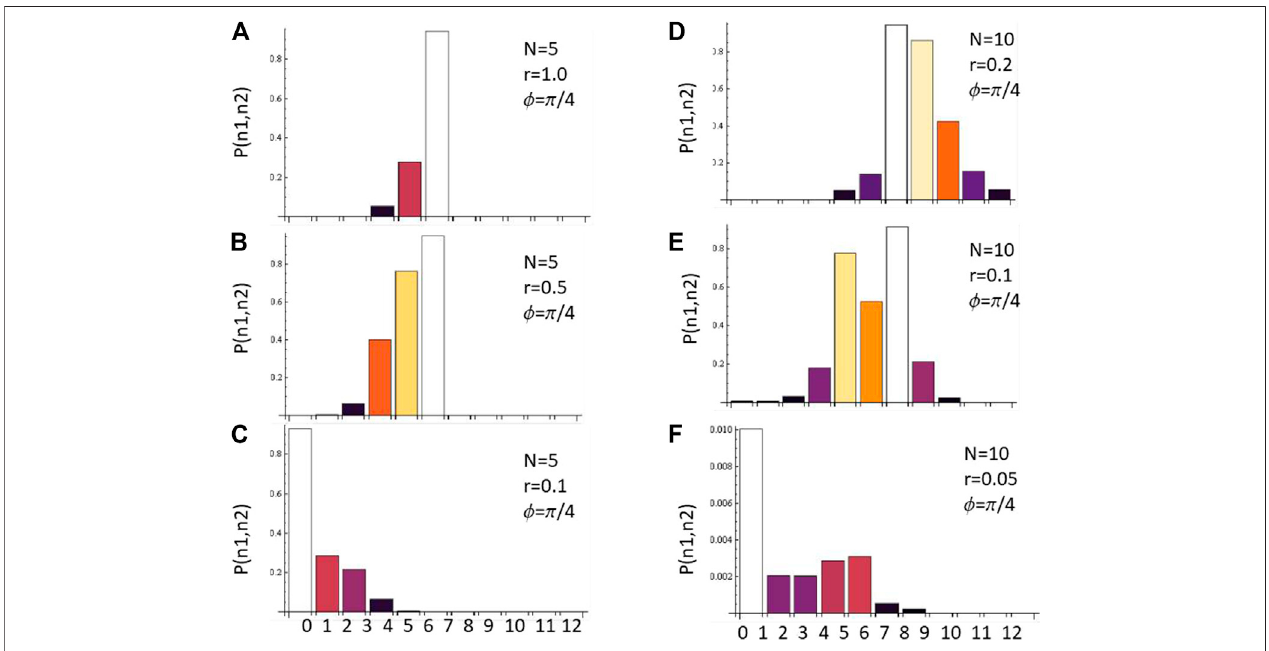
FIGURE 4 | Photon-number statistics P ( n 1 , n 2 ) for quadrature vortex states considering n 1 (cid:3) n 2 and a truncation parameter given by N photons per mode . Left column N (cid:3) 5 and ϕ (cid:3) π / 4, right column N (cid:3) 10 and ϕ (cid:3) π / 4. Different rows correspond to squeezing parameters (A) r (cid:3) 1 . 0, (B) r (cid:3) 0 . 5, (C) r (cid:3) 0 . 1, (D) r (cid:3) 0 . 2, (E) r (cid:3) 0 . 1, (F) r (cid:3) 0 . 05. The photon-number fl uctuations due to quadrature vortex formation is revealed (see text for details).